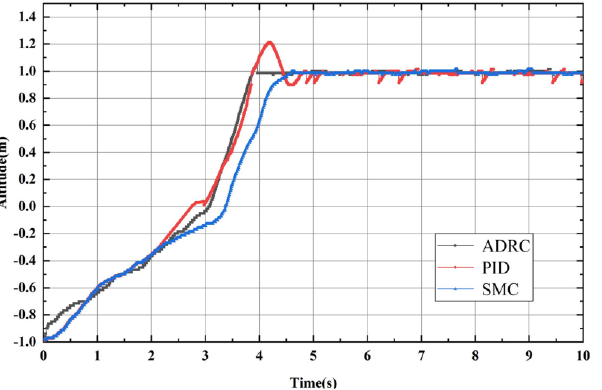
Figure 11. Comparison of experimental results of PID, SMC, and ADRC water outlet motion height control. height